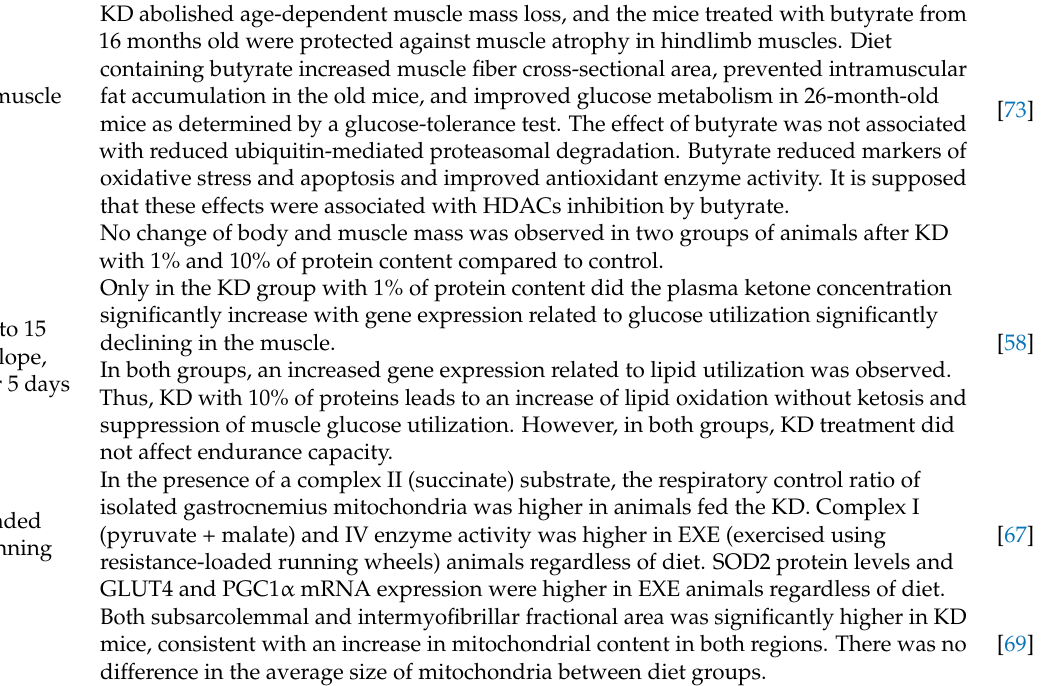
for 60 min for 5 days